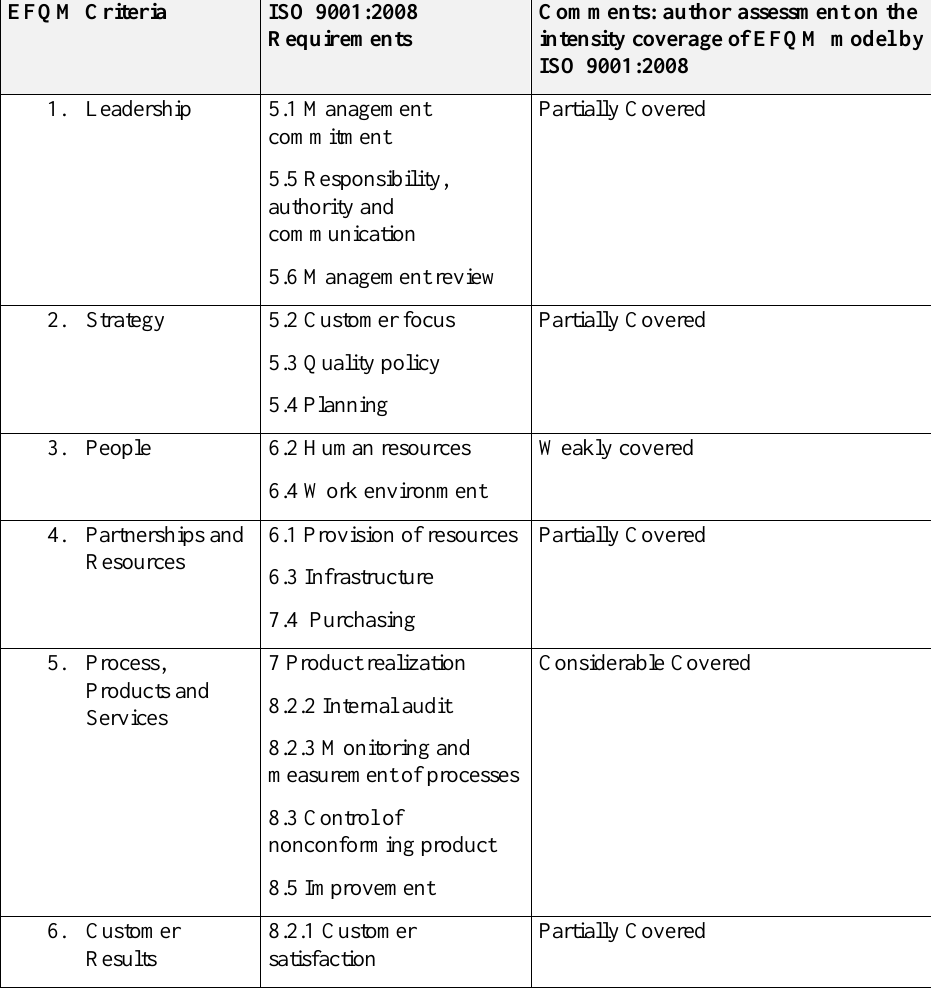
Table 1 – Comparison between ISO 9001:2008 and EFQM Business